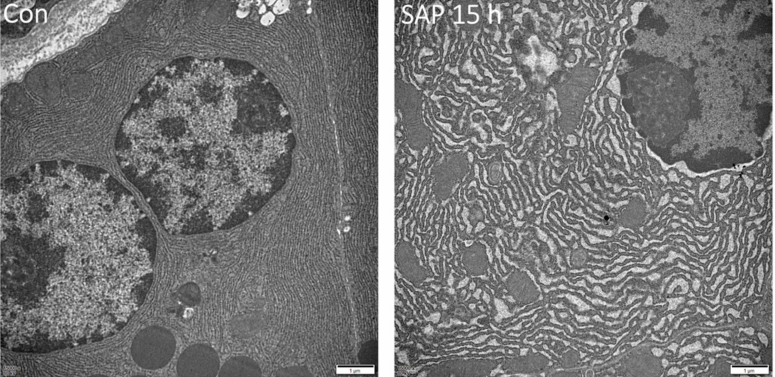
Figure 2. Ultrastructure of pancreas. Control (Con) group showed entirely normal acinar architecture. severe acute pancreatitis (SAP) group showed vacuolization, dilatated endoplasmic reticulum (ER) and cytolysis ( ×